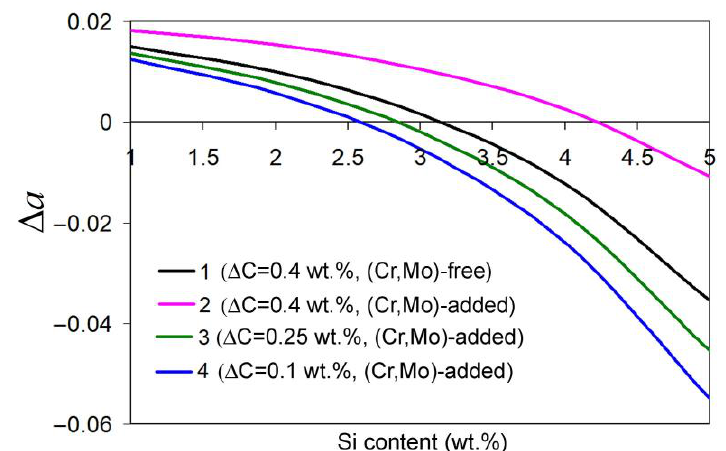
Figure 10. Effect of the Si content on the total change in free energy of austenite caused by cement- ite precipitation. cementite